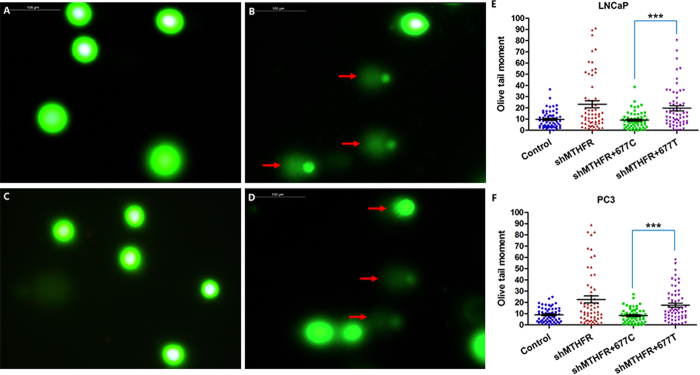
MTHFR c.677T variant causes DNA damage.(A) Comet Assay results in control cells. (B) Comet Assay results in MTHFR-knockdown cells, indicating that down-regulation of MTHFR leads to DNA damage. (C) Comet Assay results in MTHFR-knockdown + wild-type overexpressed cells, indicating that overexpression of 677C-MTHFR can reduce DNA damage. (D) Comet Assay results in MTHFR-knockdown + 677T-MTHFR overexpressed cells, indicating that overexpression of 677T-MTHFR cannot reduce DNA damage. (E) Quantitative Comet Assay results in LNCaP cells, indicating that c.677T variant might cause DNA damage compared with wild-type MTHFR. (F) Same results are achieved in PC3 cell lines. Red arrow points out the tails, which indicate DNA damage.